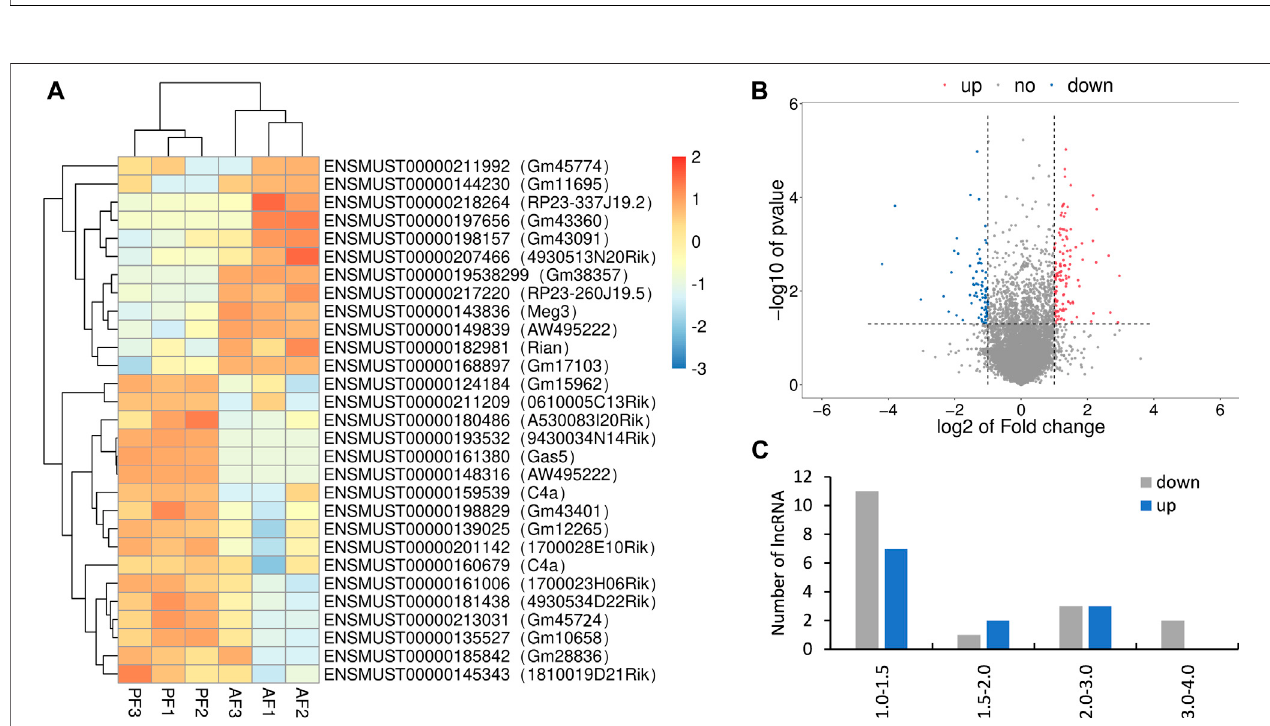
FIGURE 2 | Overview of the RNA sequencing signatures. (A) Volcanic map of differentially expressed lncRNAs. (B) Hierarchical clustering of the differentially expressed lncRNAs. (C) Categories of the 29 differentially expressed lncRNAs.